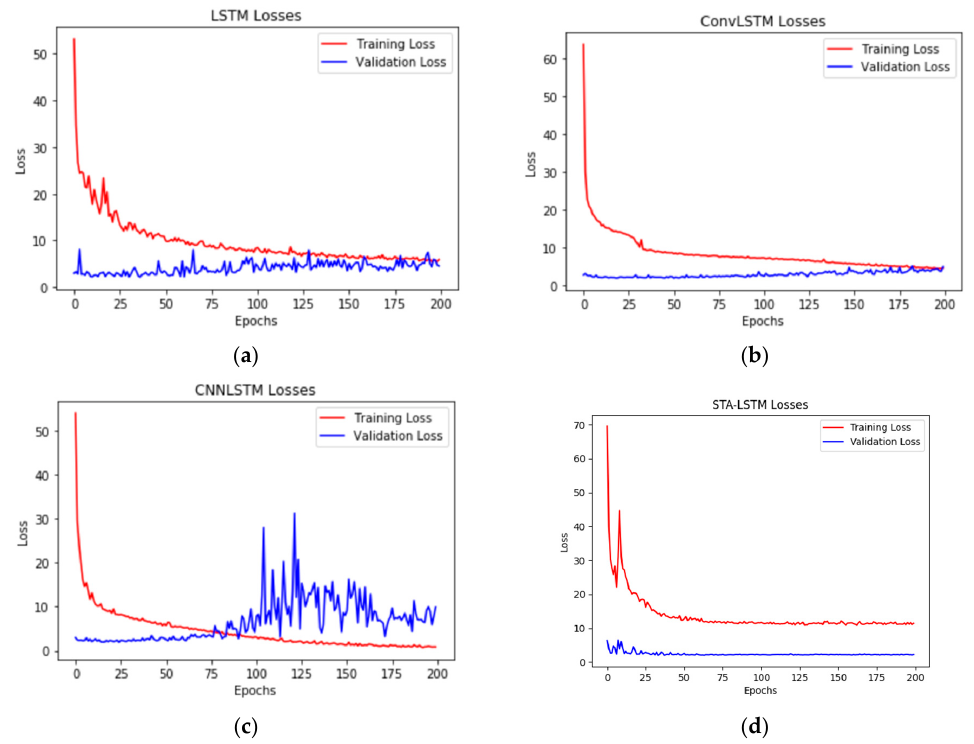
Figure 7. Training error and validation error by 12 h-ahead for the LSTM model ( a ), ConvLSTM model ( b ), CNN-LSTM model ( c ), and STA-LSTM model ( d ). By building a longer forecasting time, residents in flood risk areas will have adequate time to evacuate, ensuring the highest degree of safety. Preceding this, the 24 h-ahead forecasting model is run to determine the training and validation error. The training and validation error for the 24 h-ahead LSTM model, ConvLSTM model, CNN-LSTM model, and STA-LSTM model are given in Figure 8.